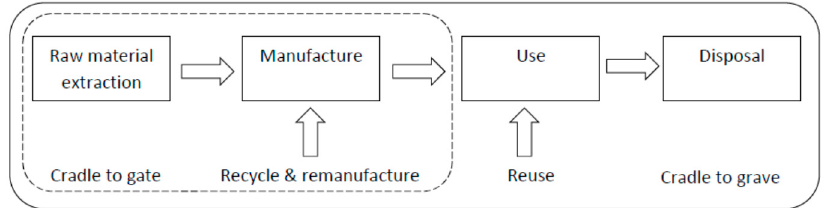
Figure 10. Life cycle stages.